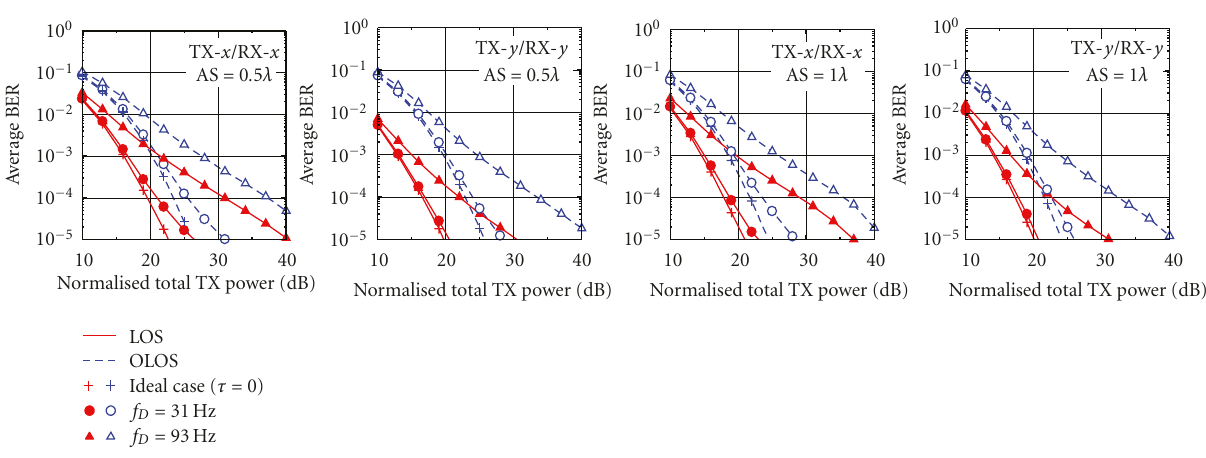
(a) RX array motion along the x -axis